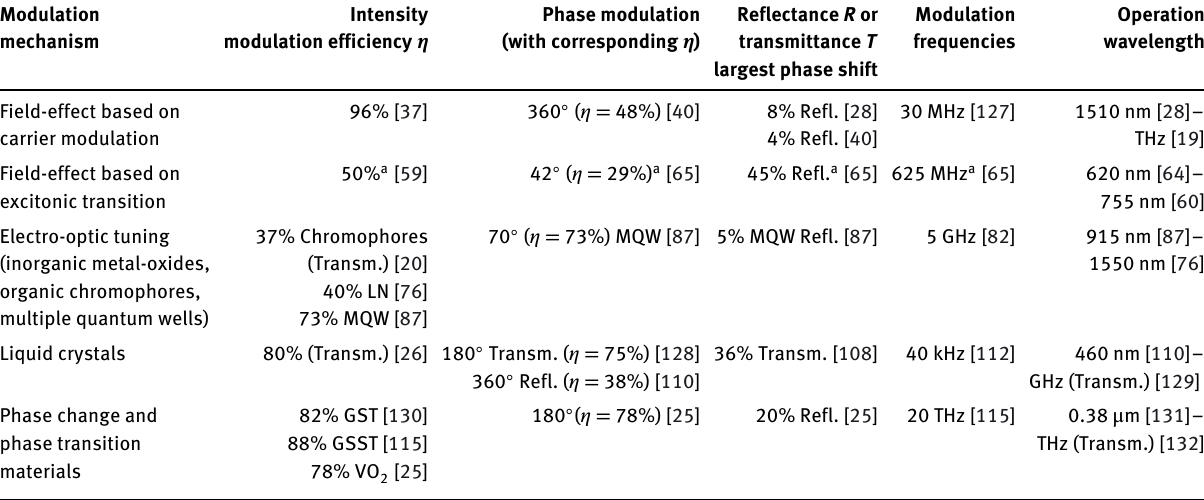
Table 2: Summary of experimentally demonstrated values for the intensity modulation efficiency 𝜂 , phase modulation, and the corresponding reflectance ( R ) or transmittance ( T ) at the largest phase shift, as well as the modulation frequencies and the operation wavelength regime. The modulation frequency refers to the highest frequency at which the amplitude response of an active metasurface resembles the applied signal. All reported values are for nanophotonic structures operating in reflection unless otherwise